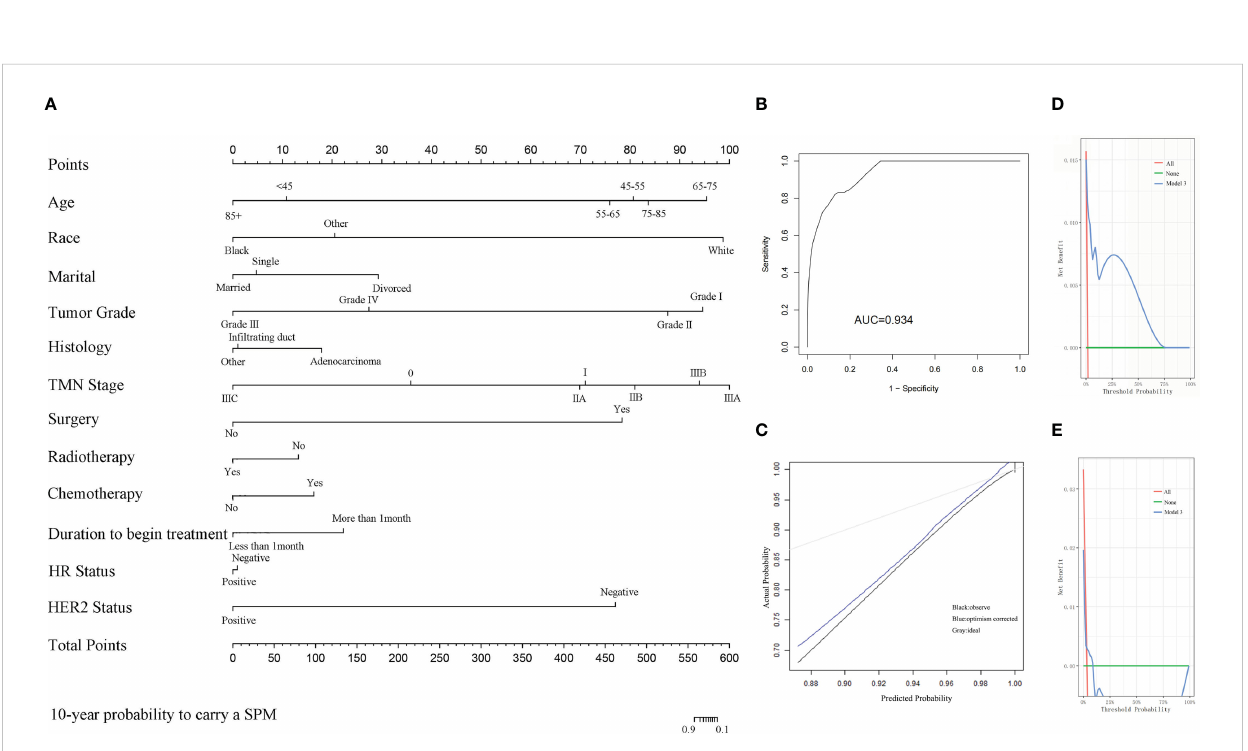
FIGURE 6 (A) The nomogram of model 3 for predicting the 10-year probability of MBC survivors who suffer from an SPM. (B) The ROC curve of model 3. (C) The calibration curve of model 3. (D) The DCA of model 3 in the development cohort. (E) The DCA of model 3 in the validation